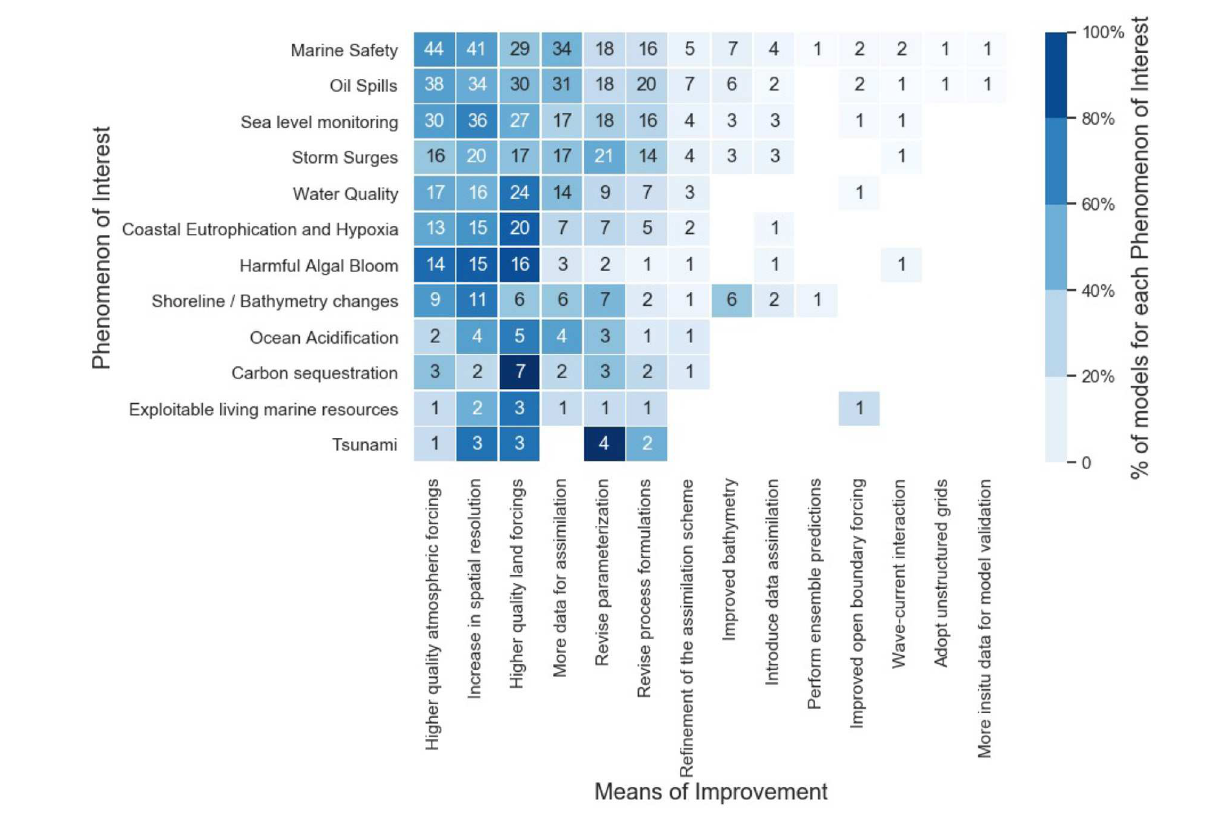
FIGURE 15 | Priority means to improve operational ocean modeling capacity categorized per POI addressed. Numbers inside each box represent the total number of